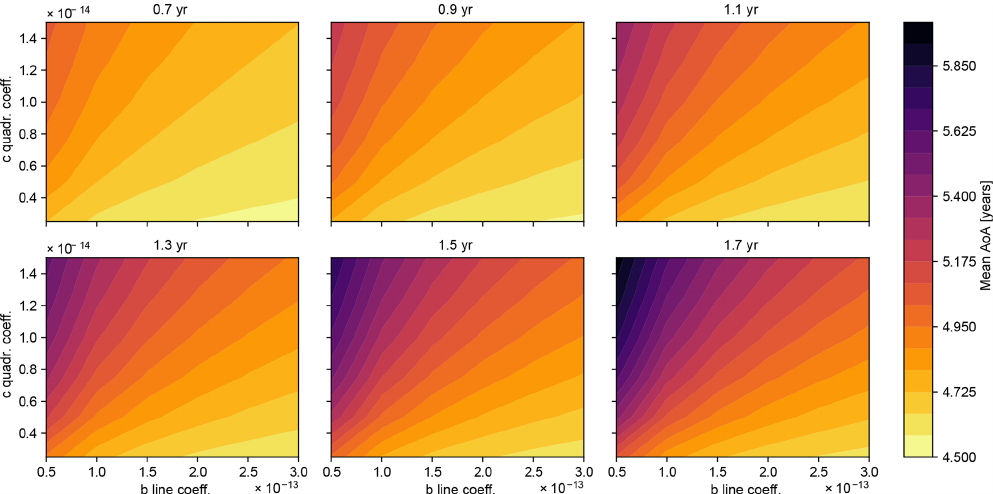
Figure 14. Mean AoA (cid:48) for the range of magnitude of the coefficients b and c based on Eq. (7) using the fixed τ = 4 . 5 years. The different panels show the respective ratio of moments